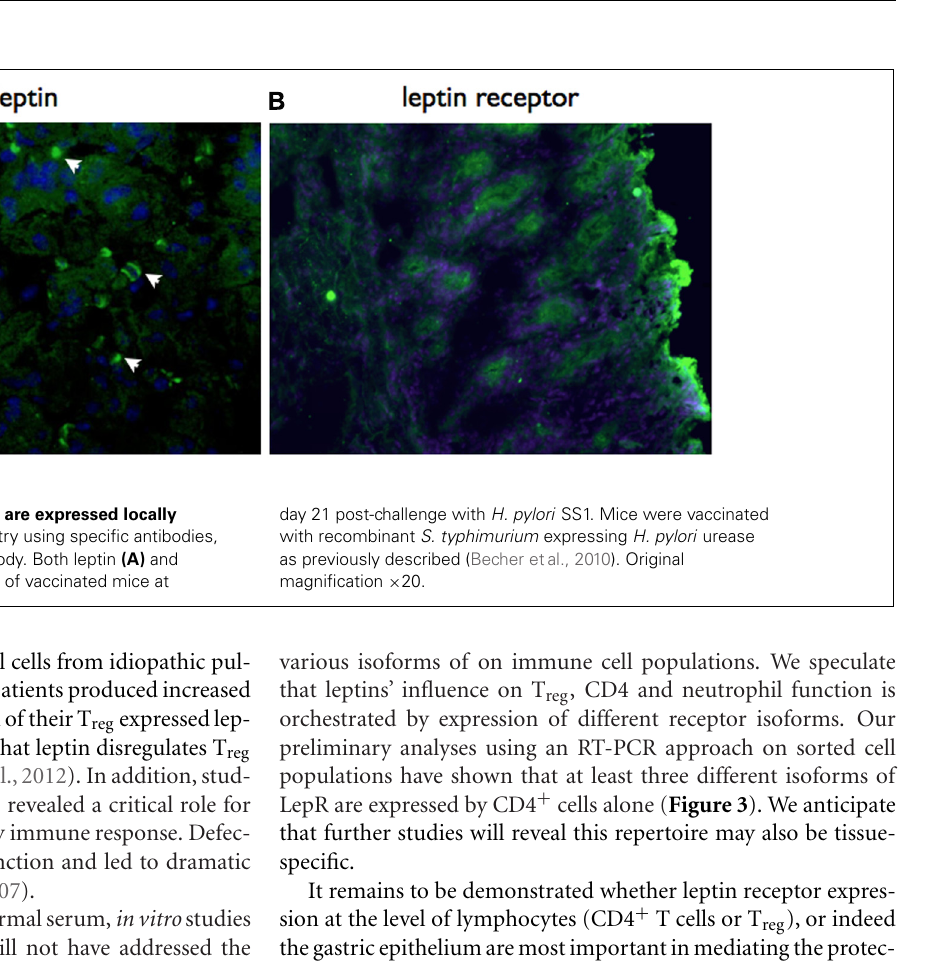
day 21 post-challenge with H. pylori SS1. Mice were vaccinated with recombinant S. typhimurium expressing H. pylori urease as previously described (Becher etal., 2010). Original magnification × 20.